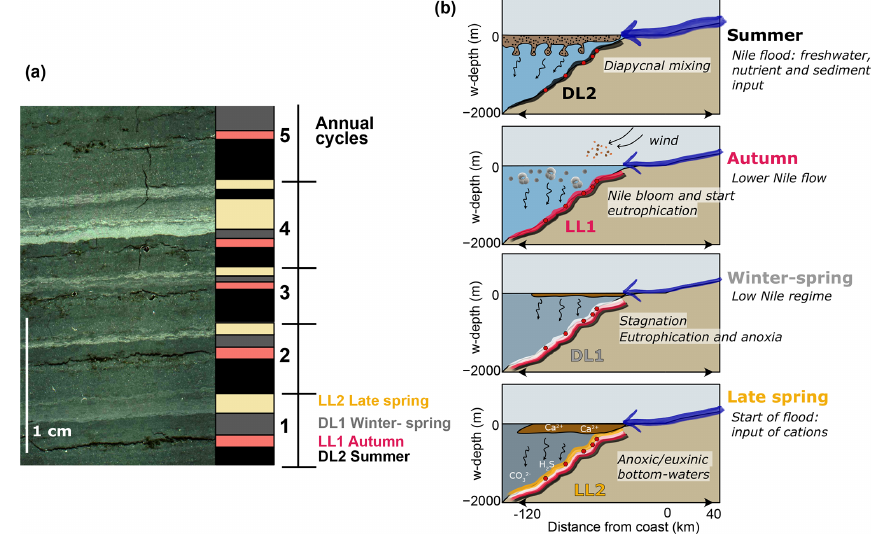
Figure 9. (a) Seasonal succession of sublayers and (b) schematic seasonal cycle on the Nile DSF. (a) From left to right: part-polarized microscope image, sublayer identification, determined season for each sublayer type and number of annual cycles in the sample. (b) Sketches of an annual cycle as derived from microfacies analyses from summer (top) to late spring